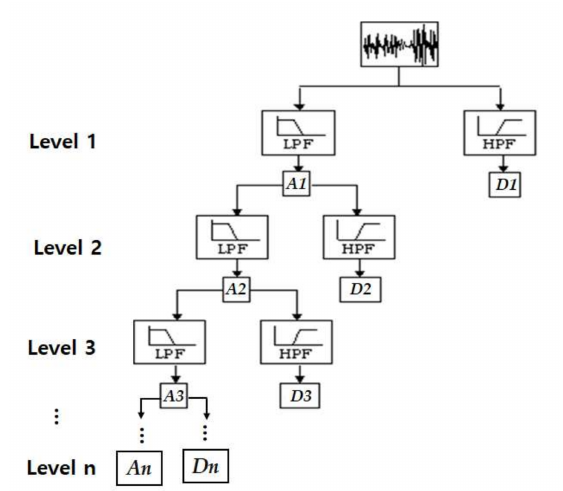
Figure 8. Decomposition tree for WT